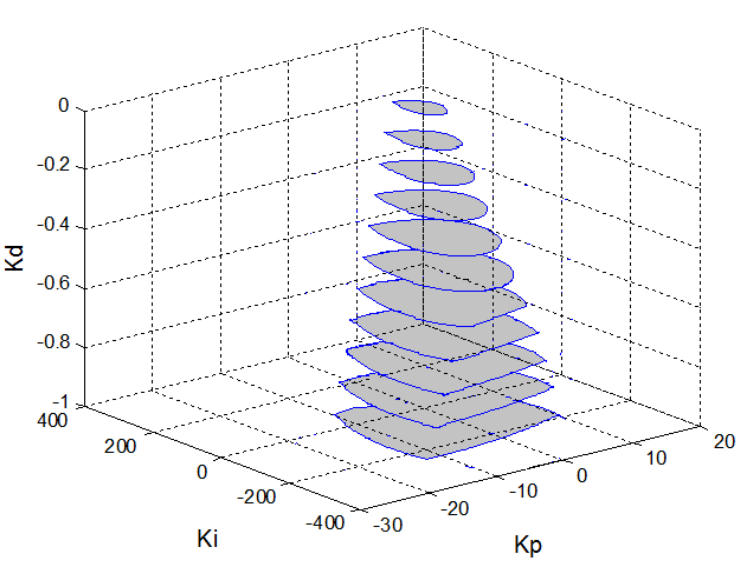
Figure 15. The stabilizing region in